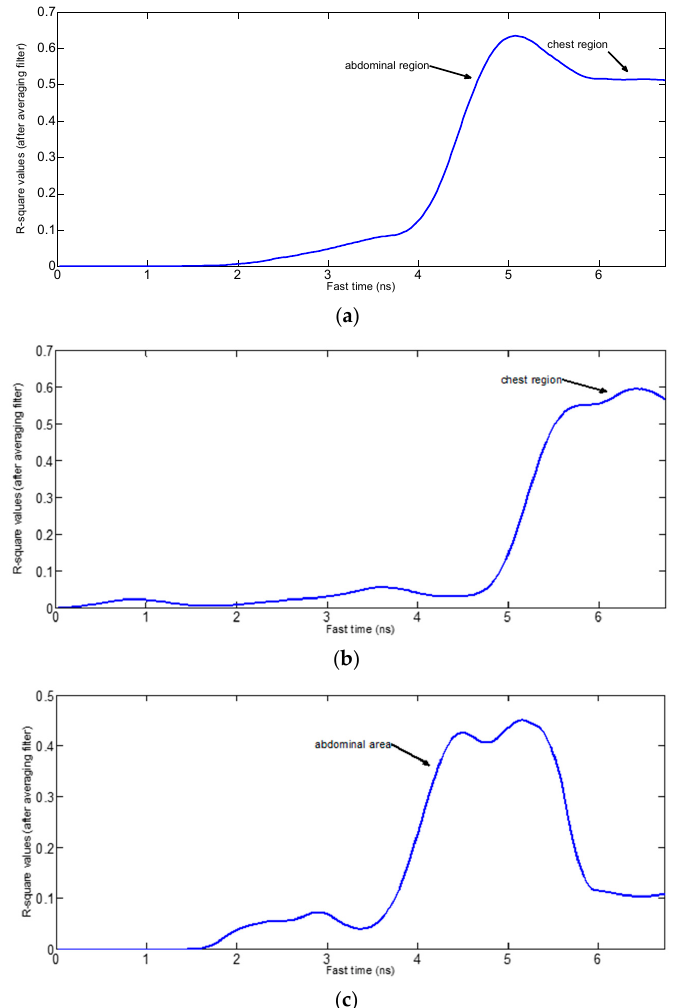
Figure 5. R square values while ( a ) stationary ( b ) moving hand near abdominal region ( c ) moving upper parts of body slightly.